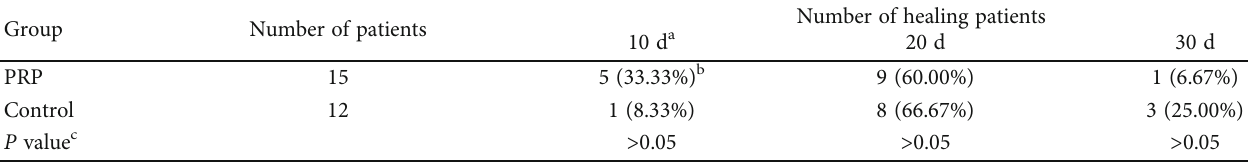
Table 3: Comparison of therapeutic e ffi cacy at di ff erent therapeutic intervals in peptic ulcer healing.